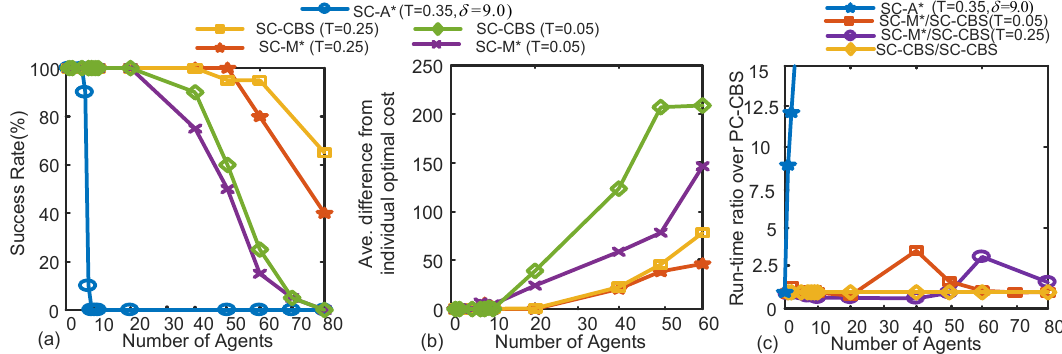
Figure 9. Success rate, cost, and run time ratio of the three SC-based MAPP solvers under different T